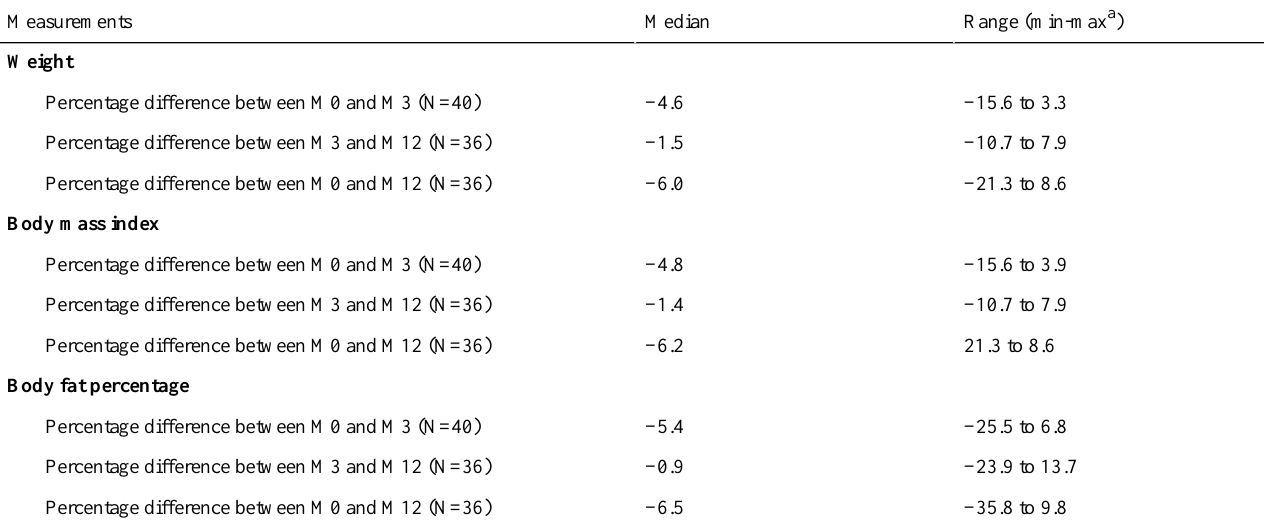
Table 3. Percentage changes between baseline (M0), 3 months (M3), and 12 months (M12) in weight, body mass index, and body fat